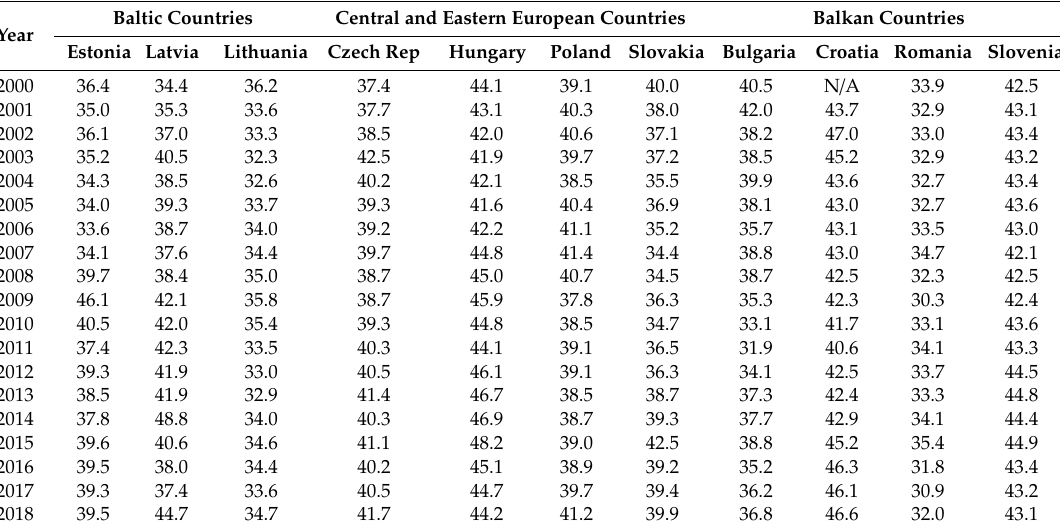
Baltic Countries Central and Eastern European Countries Balkan Countries Year